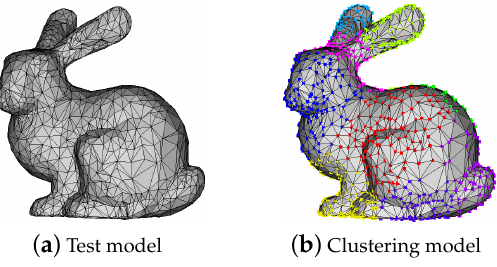
Figure 2. Cluster strategy on test model.